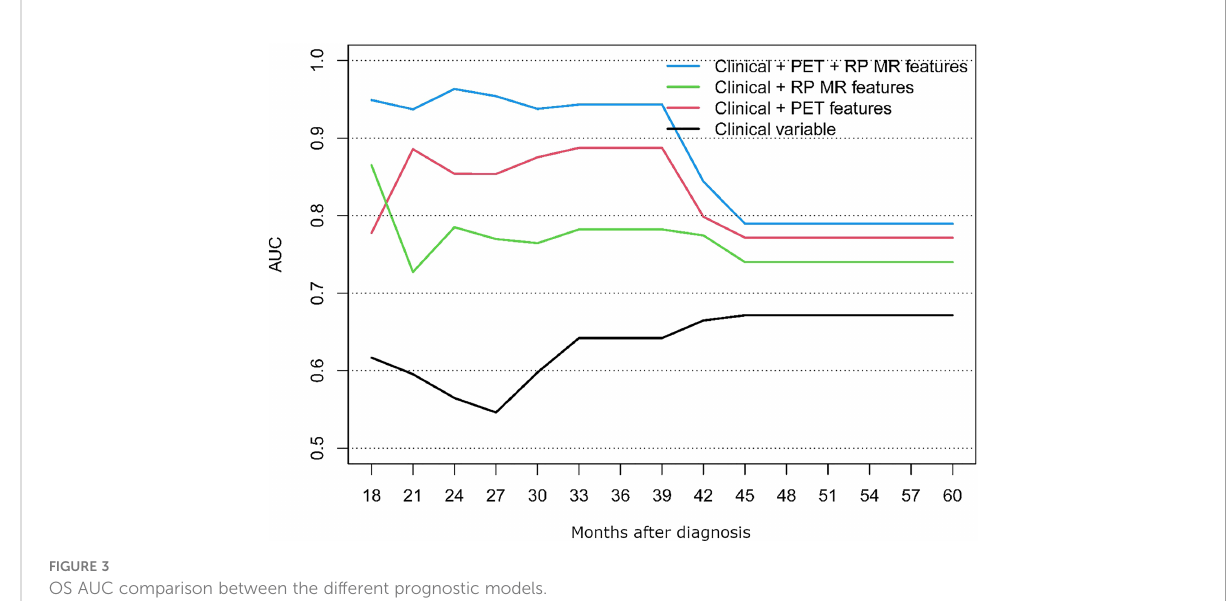
FIGURE 3 OS AUC comparison between the different prognostic models.